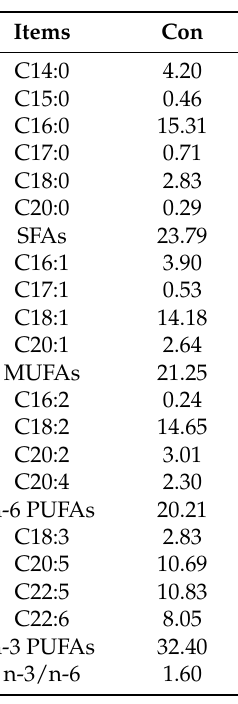
Table 3. Fatty acid composition of experimental diets (percentage of fatty acids,